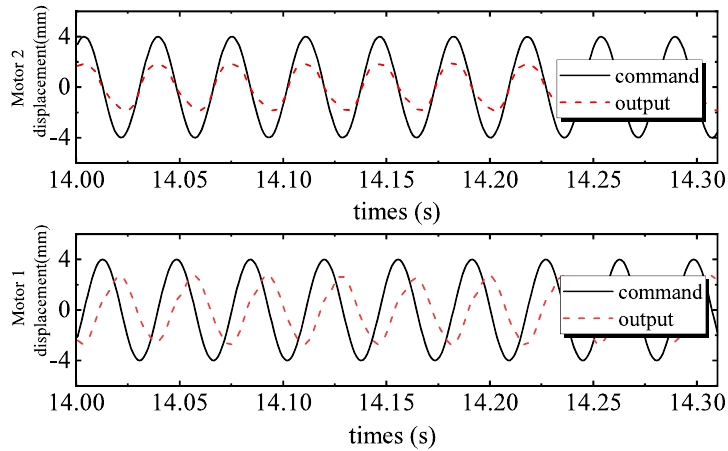
Figure 4. Proportional-integral-derivative (PID) tracking performance of two motors.